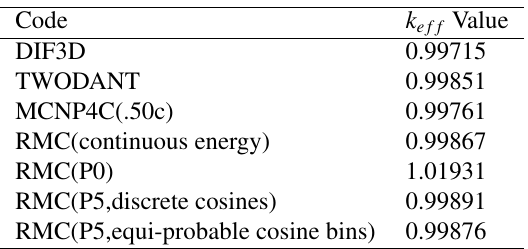
Table 1. k kef f results of di ff erent conditions